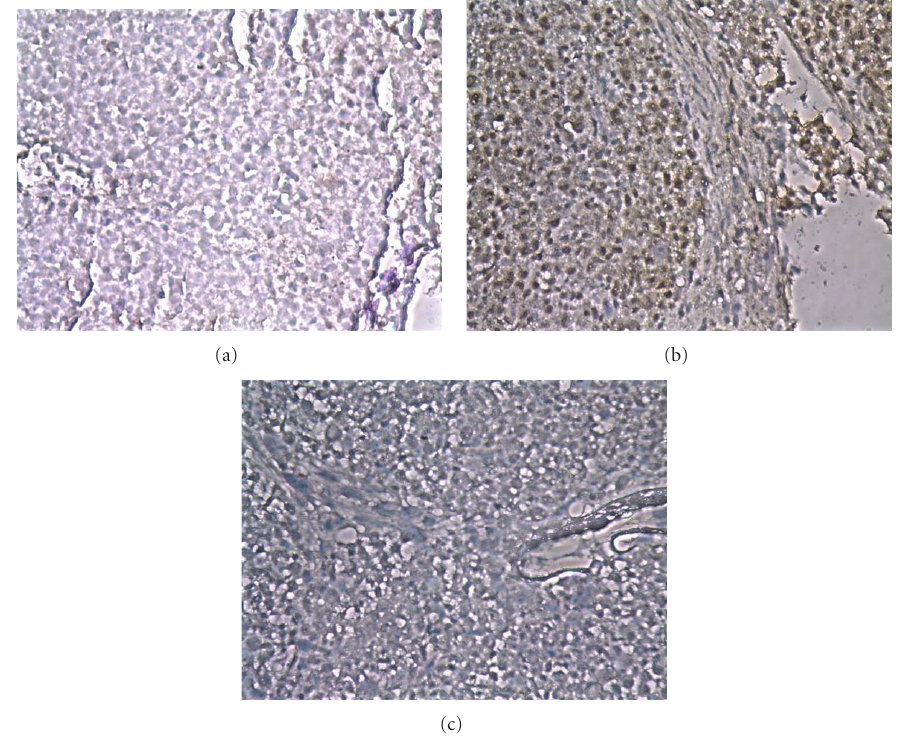
Figure 7: Representative pictures of staining of collagen type II after induction in chondrogenic di ff erentiation media for 8 weeks. (a) Weakly positive, (b) positive for collagen, and (c) isotype control (10x